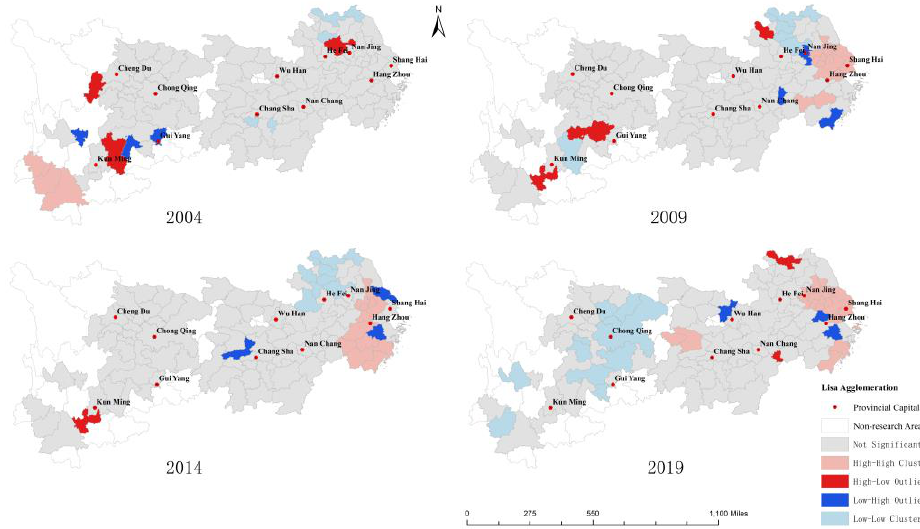
Figure 5. Lisa agglomeration index of ULUE.